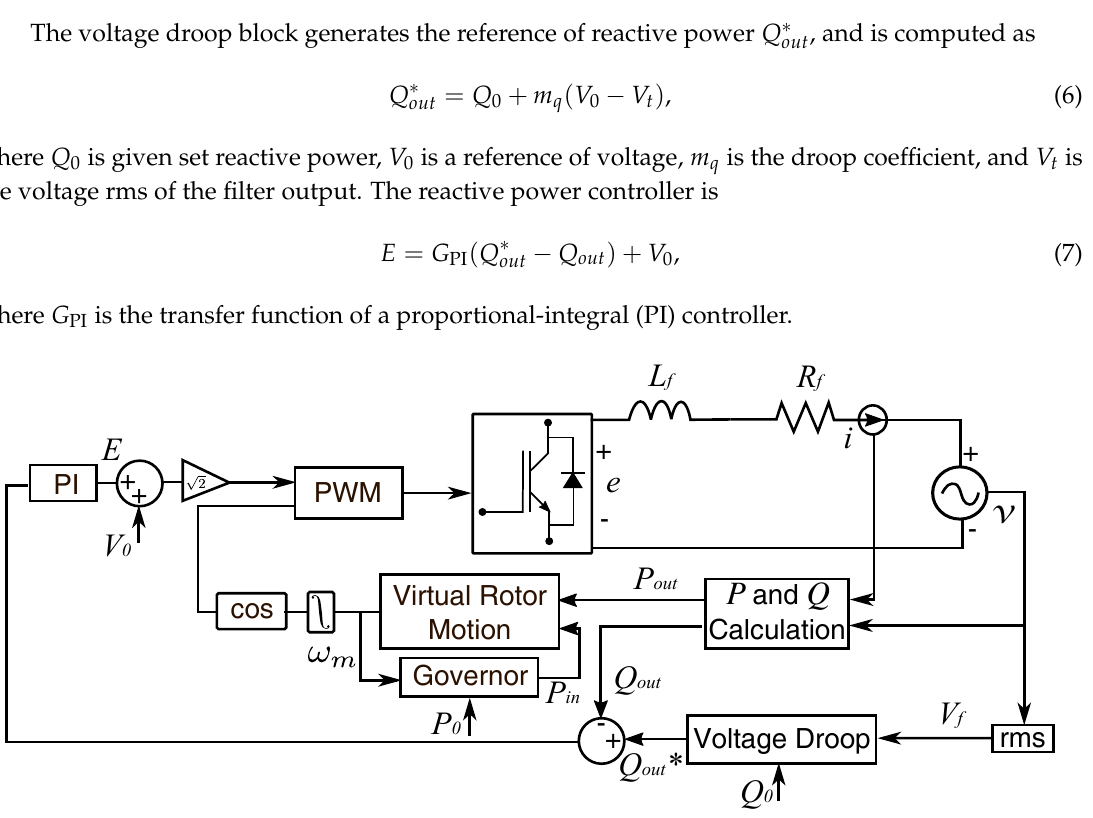
Figure 1. Control scheme for distributed generators (DGs) including virtual